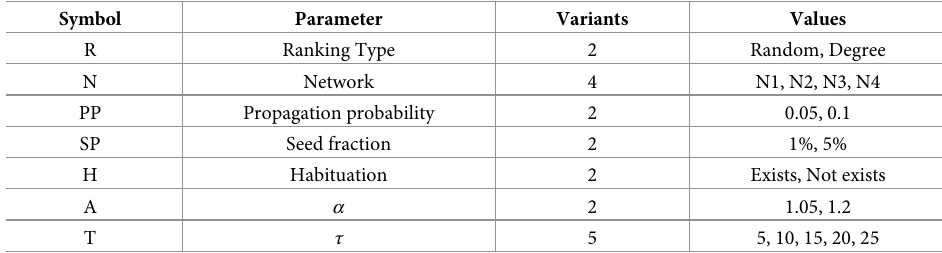
Table 2. Parameters used for diffusion in the